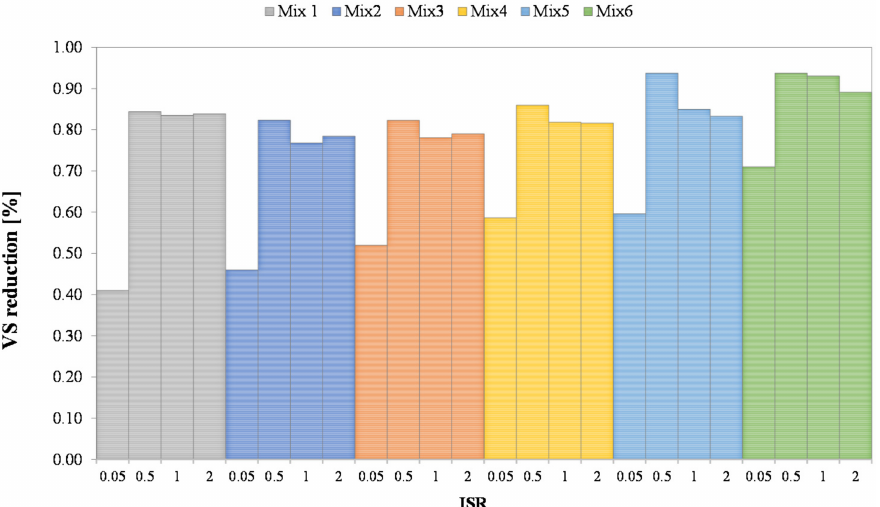
Figure 1. Reduction of VS obtained in the six mixtures of OFMSW and SS at different